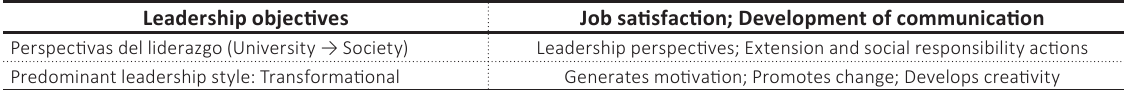
Table 4. Leadership in university